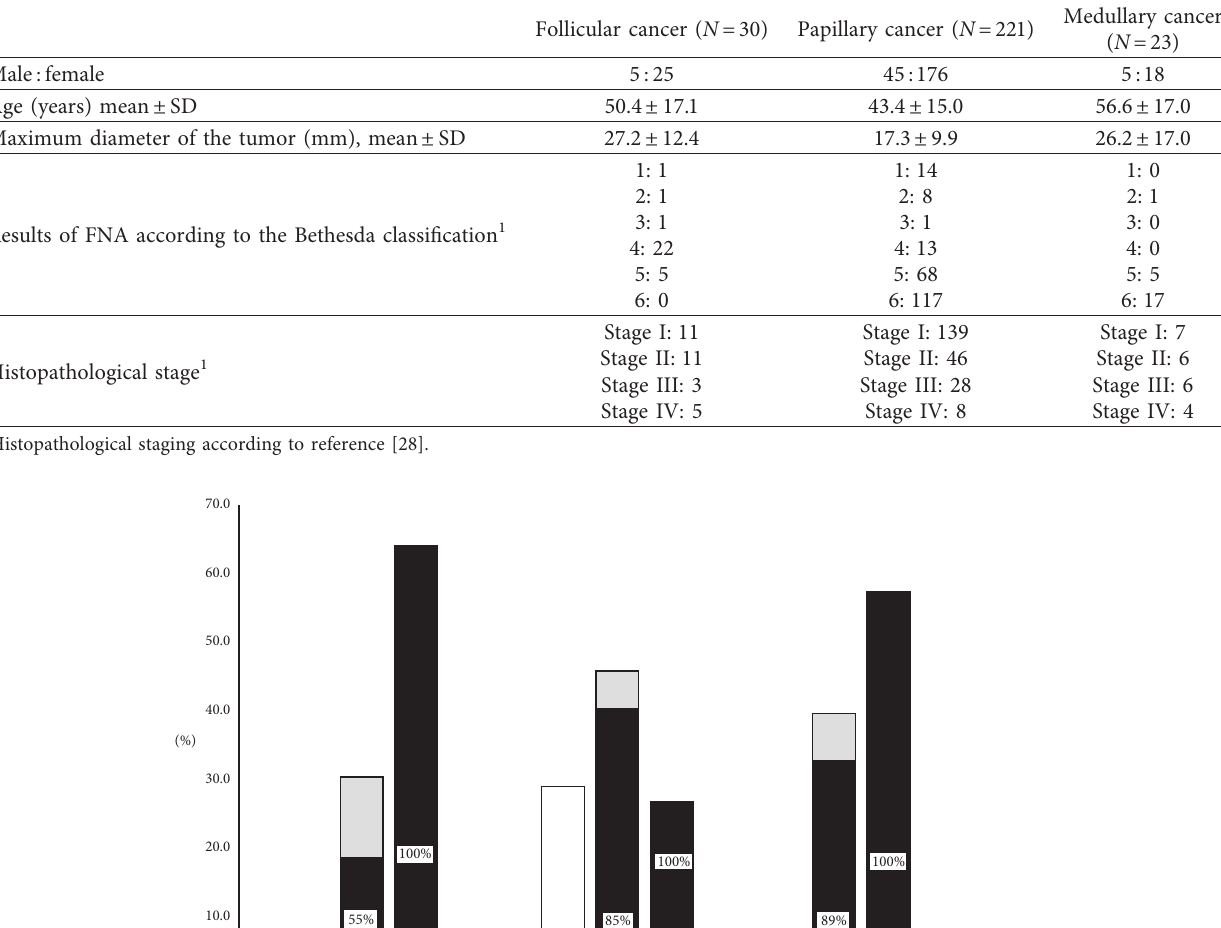
Table 1: The clinical and histopathological data of the 274 thyroid cancer patients.